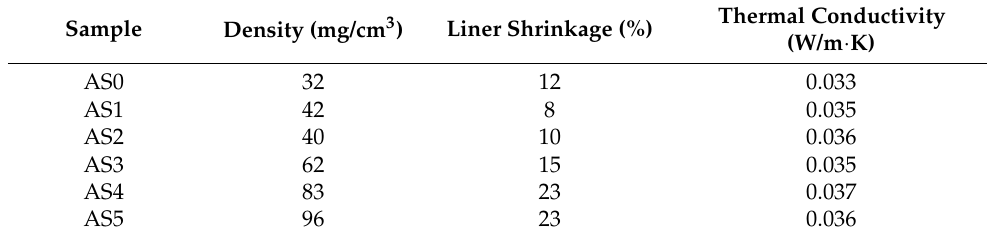
Figure 1. Digital photos of Al 2 O 3 -SiO 2 composite aerogels ( a ) AS0, ( b ) AS1, ( c ) AS2, ( d ) AS3, ( e ) AS4 and ( f ) AS5. Table 1. Density, liner shrinkage and thermal conductivity (20 °C) of the AS samples.